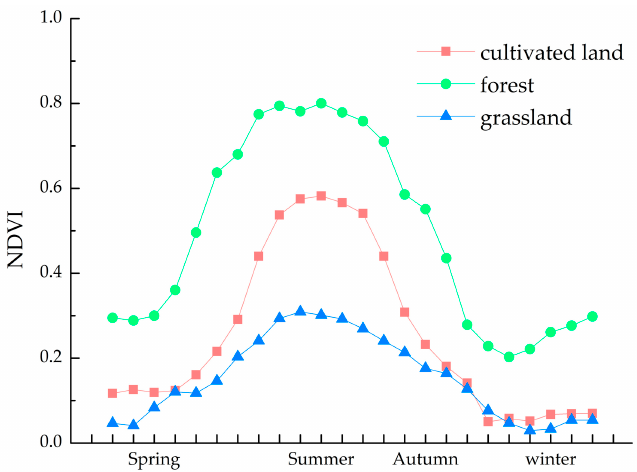
Figure 4. Temporal features in typical vegetation.